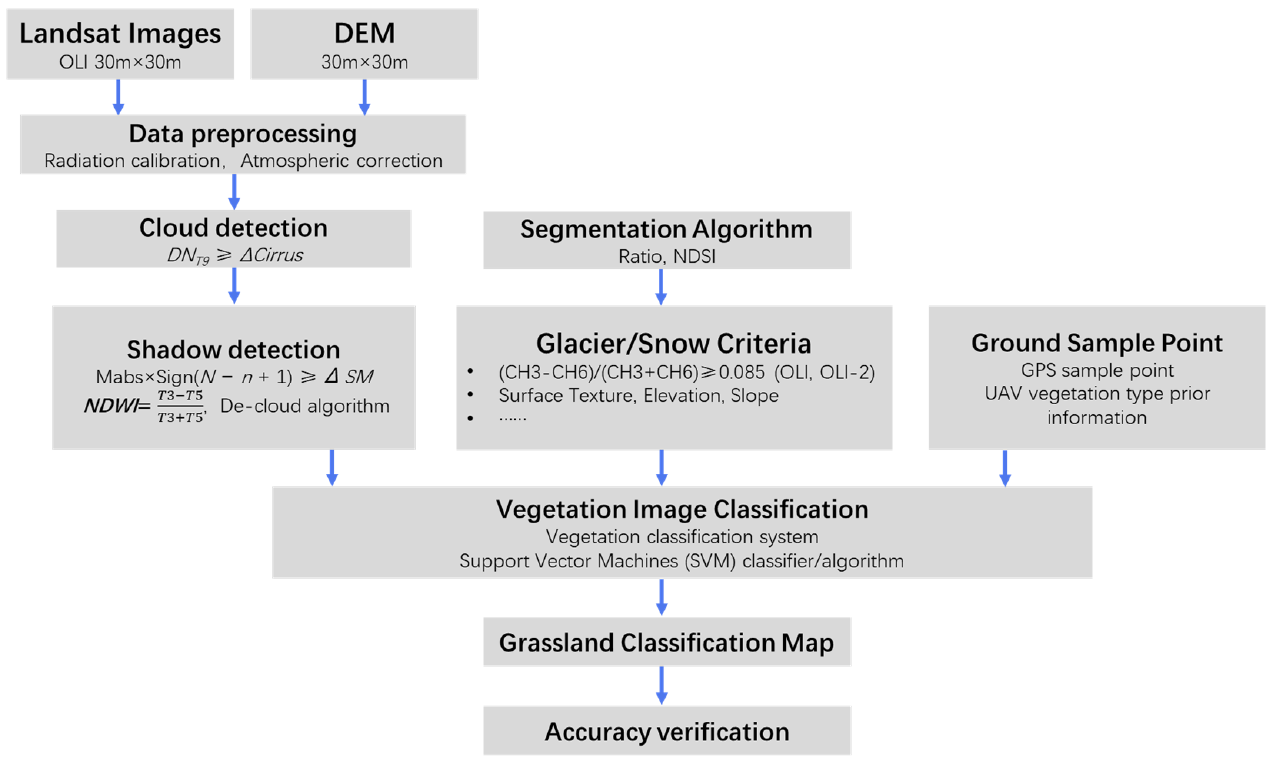
Figure 5. Vegetation classification and extraction workflow.